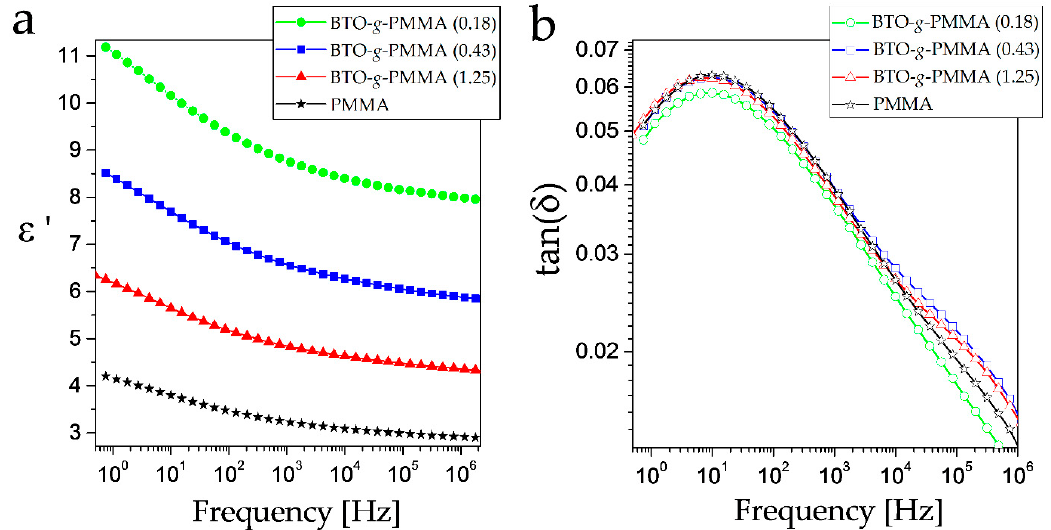
Figure 2. Frequency dependence of real part of dielectric permittivity ( a ) and loss tangent ( b ) for BTO- g -PMMA nanocomposites determined at 20 °C.